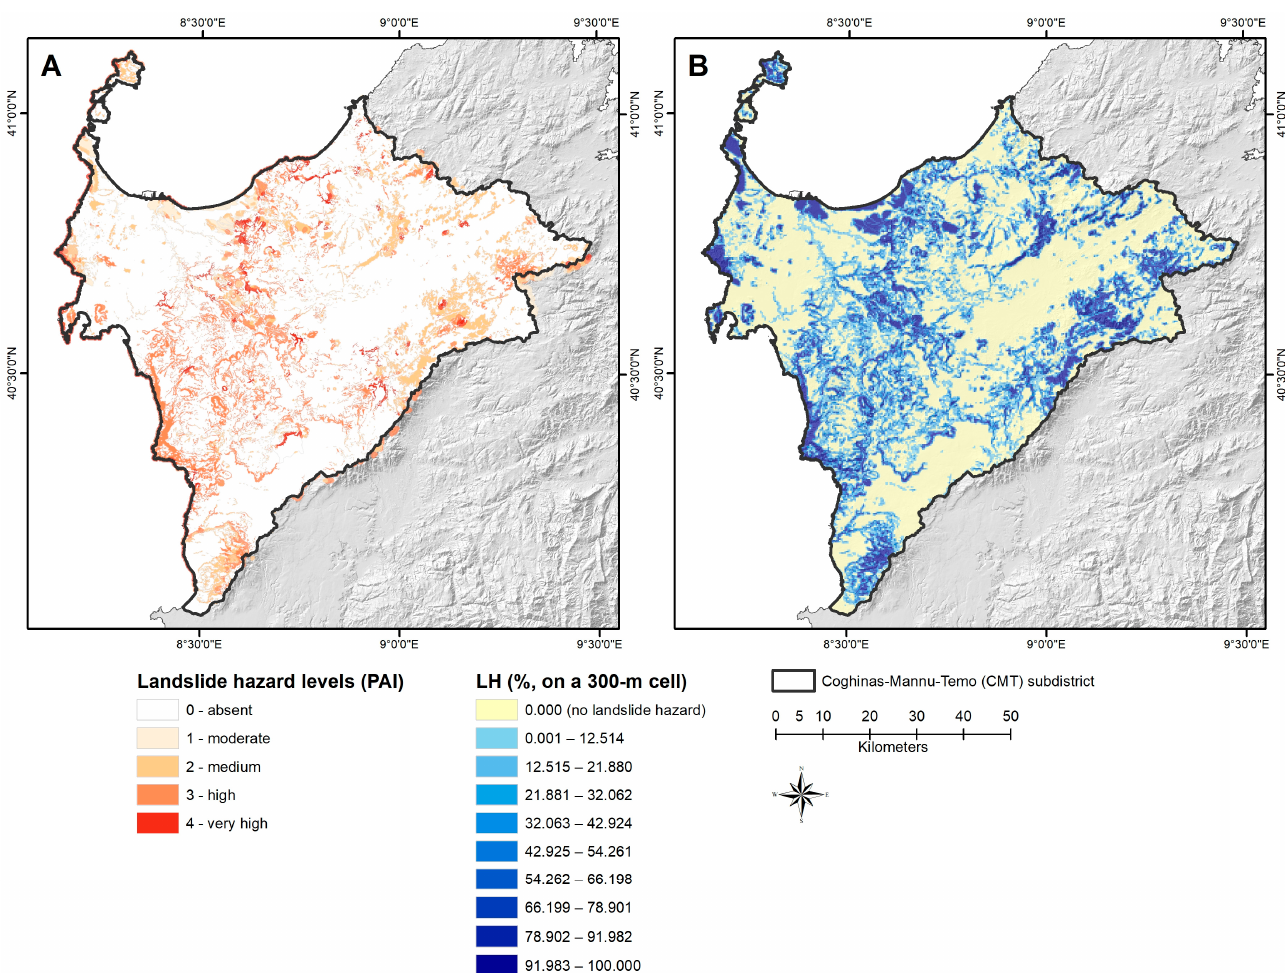
Figure 4. Landslide hazard levels as assessed by the regional PAI in the Coghinas-Mannu-Temo subdistrict (panel A ), and spatial distribution of the LH variable in the 300 m grid used in this study (panel B ).